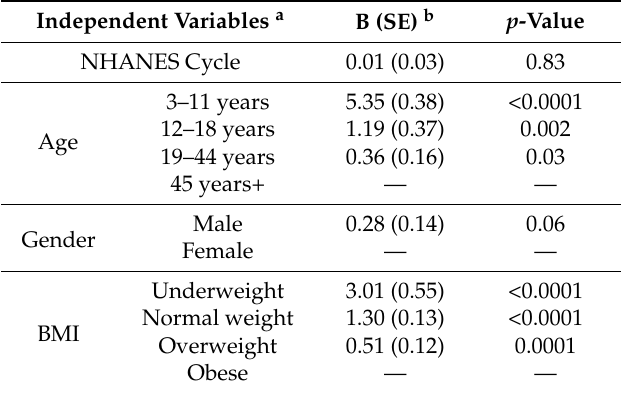
Figure 2. Percent of each population group identified as consumers of cooked oatmeal. Percentage of respondents identified as consumers of cooked oatmeal within the 2003–2004, 2005–2006, 2007–2008, 2009–2010, and 2011–2012 cycles of the NHANES. A respondent was considered a consumer of cooked oatmeal if they consumed any of the foods represented by the food codes listed in Table 1 on Day 1 of the survey. Table 7. Multiple linear regression analysis of the consumption of cooked